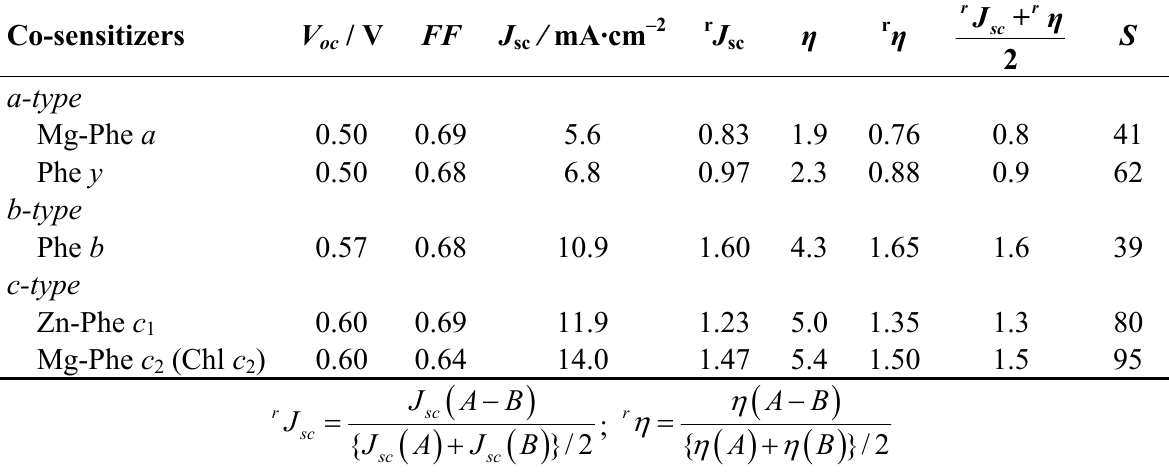
Table 5. The open-circuit photovoltage ( V ), fill factor ( FF ), short-circuit photo-current oc density ( J ), conversion efficiency ( η ) of the solar cells co-sensitized, and the spectral sc separation (S). The definitions of r J and r η are given below the sc